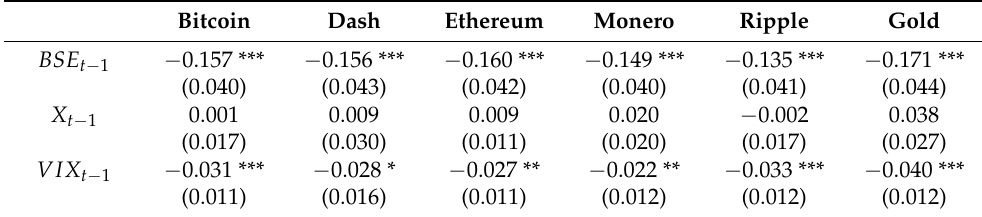
Table 11. Estimation results for BVSP during